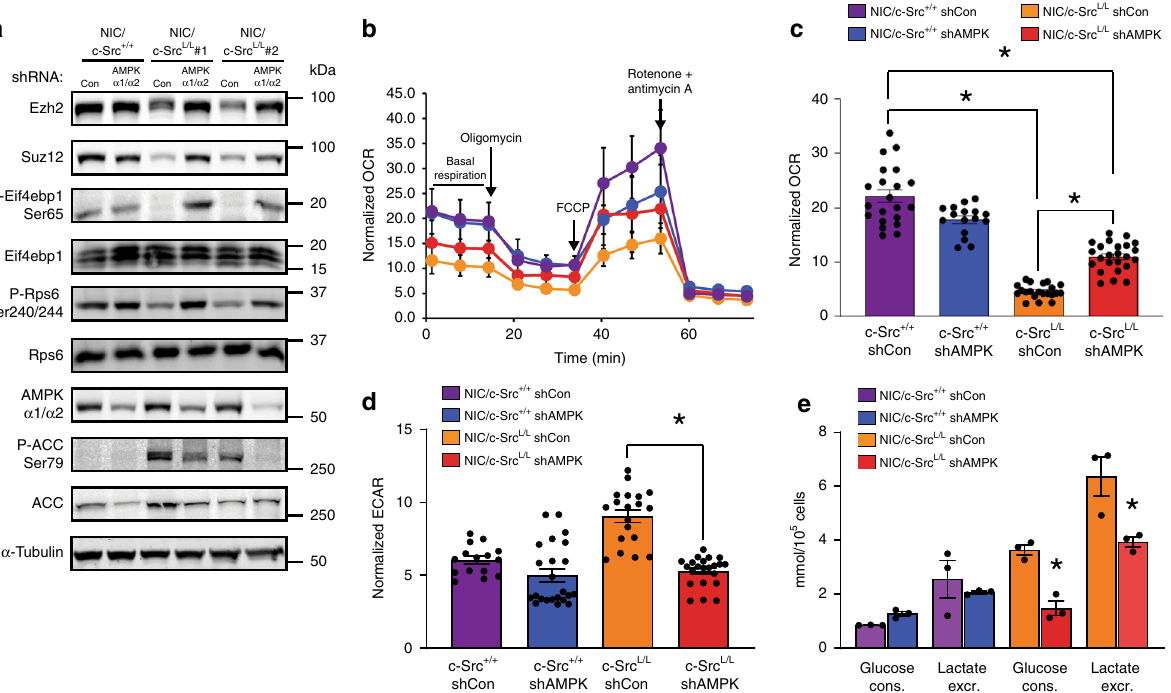
Fig. 7 AMPK α silencing partially reverses metabolic phenotypes of c-Src-de fi cient cells. a NIC/c-Src + / + cells and two independent NIC/c-Src L/L cell lines were transduced with a retrovirus bearing shRNAs against Prkaa1 and Prkaa2 (AMPK α 1 and AMPK α 2). Immunoblots show expression of PRC2 components, mTORC1 activation and AMPK α 1/ α 2 expression and activity. b Basal, maximal (FCCP), ATP-synthesis-coupled (Oligomycin A), and non- mitochondrial (rotenone/antimycin A) oxygen consumption rates (OCRs) of NIC cell lines expressing control or AMPK α 1/ α 2 shRNAs. Representative of 2 cell lines per genotype. c , d Quanti fi cation of basal OCR and ECAR of cells as in b . e Glucose consumption and lactate levels in conditioned media from cells as in b . All bar charts show mean ± SEM, with * = p < 0.05 and ** = p < 0.01 (unpaired, two-tailed Student ’ s t